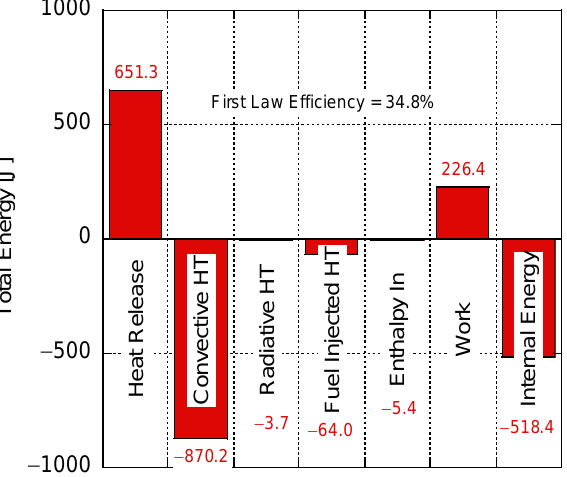
Figure 9. The cumulative energy components of the conservation of energy equation. If the theoretical heat release is computed through the species correctly, recalling the discussion around Equation (68) indicates that it would be possible to back calculate the theoretical convective heat transfer rate that balances the first law at each crank angle. This could be used to develop a new heat transfer correlation that is more accurate than current models [40]. Figure 10 highlights the comparison between the calculated convective and radiative heat transfer and the theoretical convective heat transfer from Equation (68). As the calculated convective heat transfer was calibrated to match the cumulative heat release rate at EVO, it is not surprising that the curves are similar. Differences are largely seen towards the latter stages of combustion as the species are inaccurately predicted. However, the respective goodness of fit (R 2 = 0.992) lends credence to the use of the heat transfer model employed.